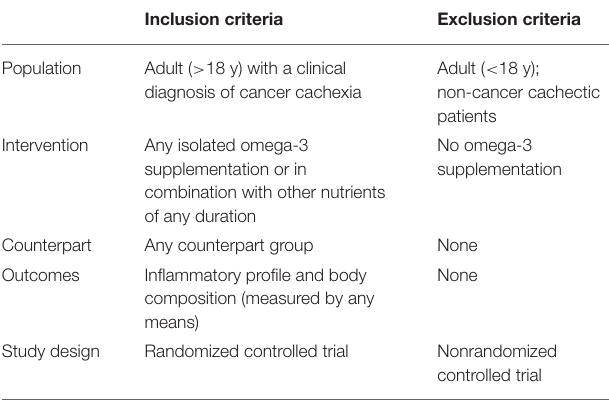
TABLE 1 | Inclusion and exclusion criteria performed by patient, intervention, comparison, and outcome (PICOS)